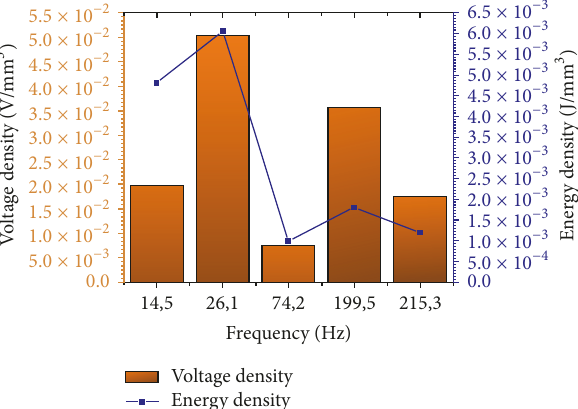
Figure 8: Summary of electrical characteristics of the